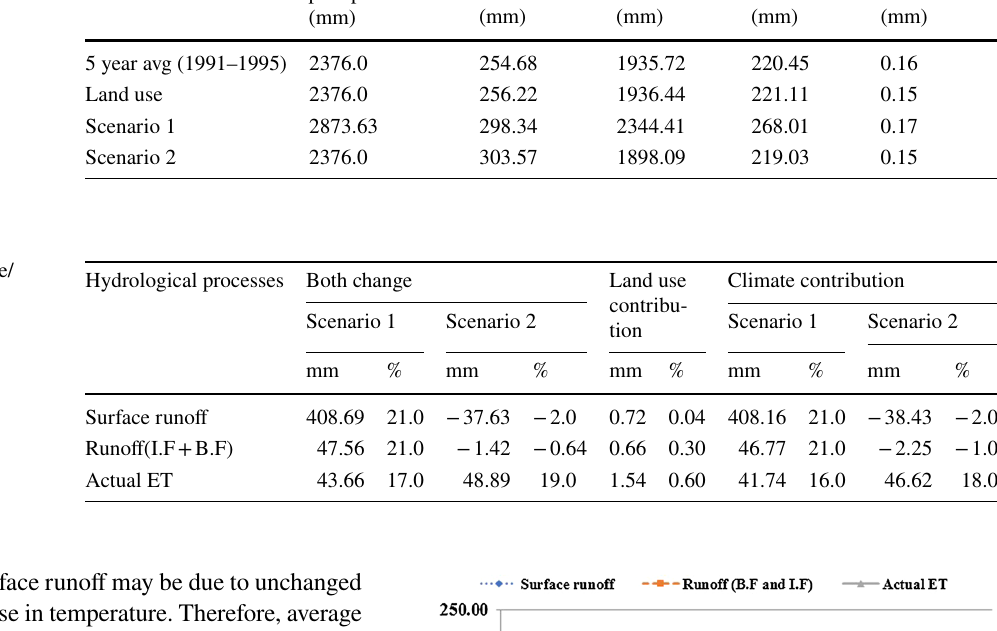
Table 6 Hydrological simulations results under different scenarios